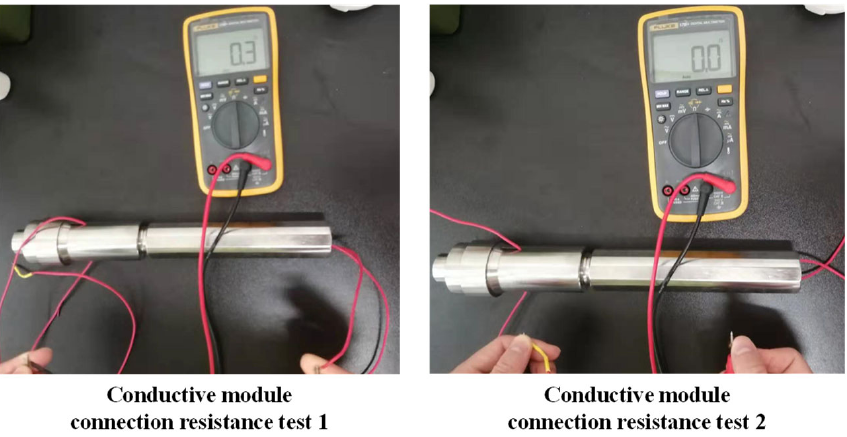
Figure 21. Physical prototype of the conductive center pole.